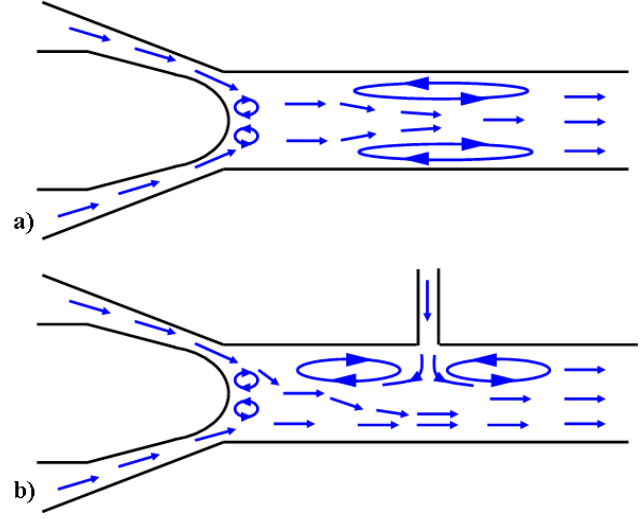
Figure 7. Velocity field ( a ) without secondary jet and ( b ) with secondary jet.